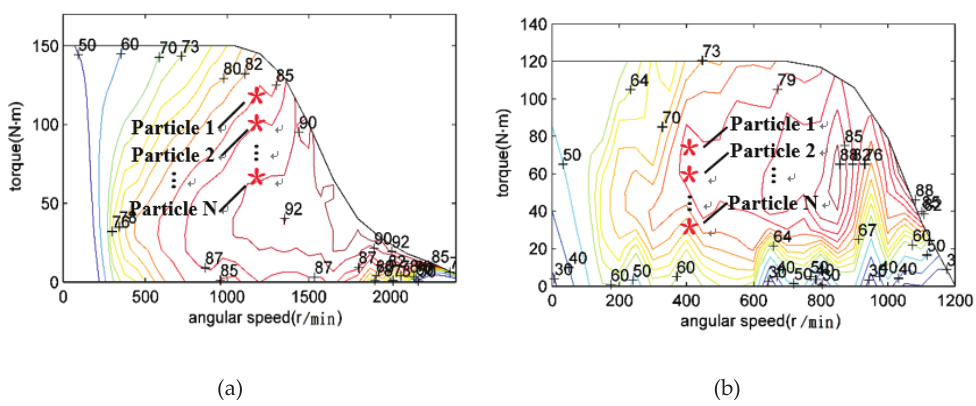
Figure 2. Torque-speed-efficiency maps: ( a ) the driving mode of the 15-kW front motor, ( b ) the driving modes of the two 7-kW rear motors.